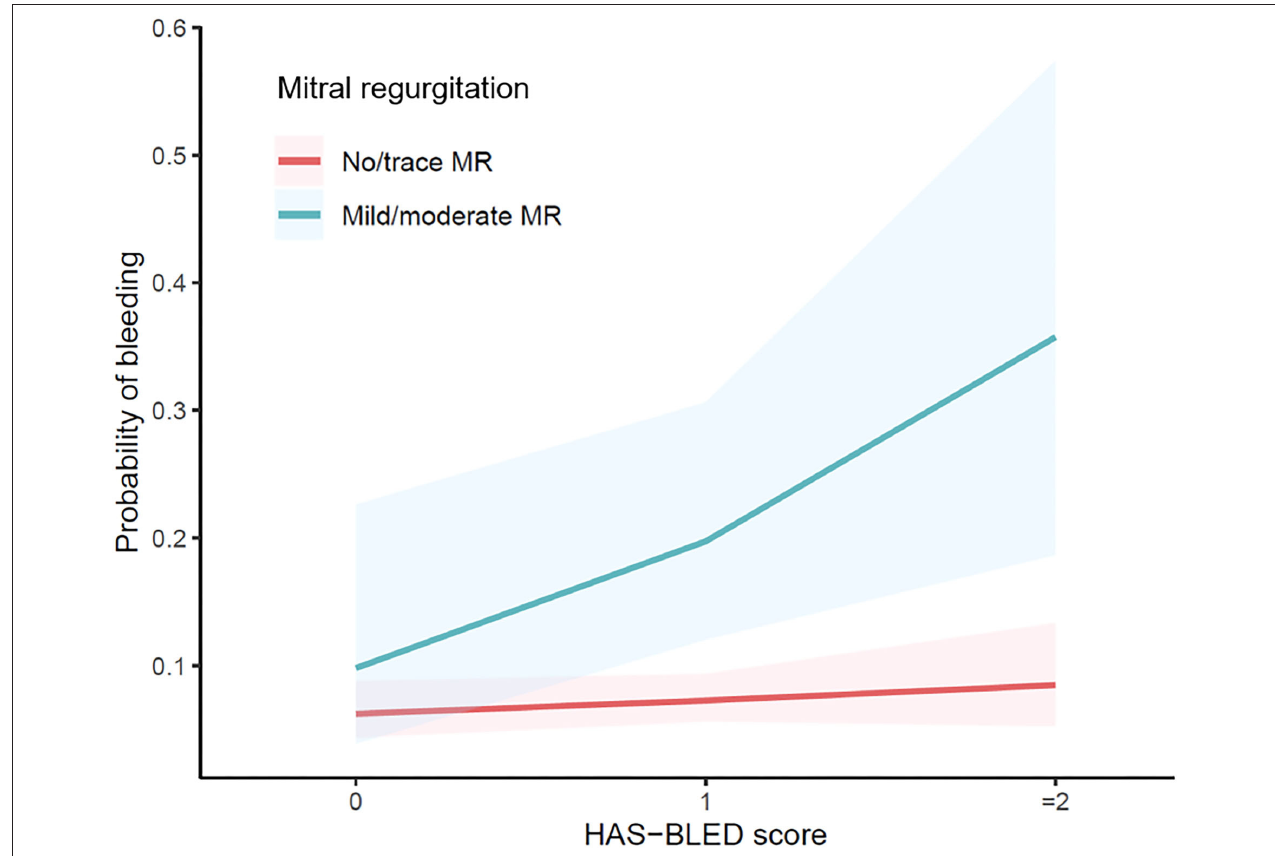
FIGURE 4 | Odds ratio of different risk categories based on the HAS-BLED score with different mitral regurgitation